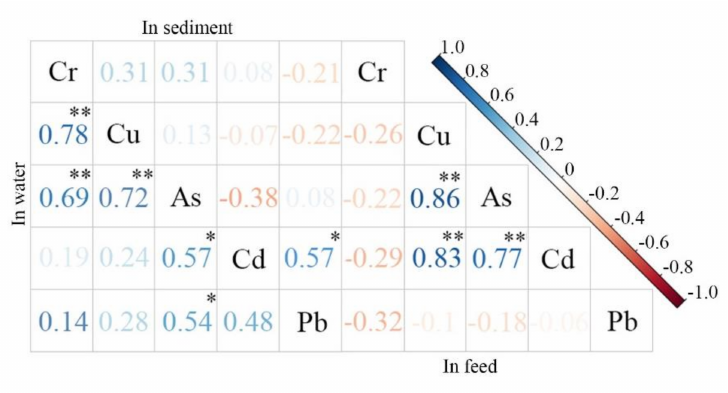
Figure 3. Correlations of metals in water, sediment and feed; Note: * represents a significant correlation, and ** represents an extremely significant